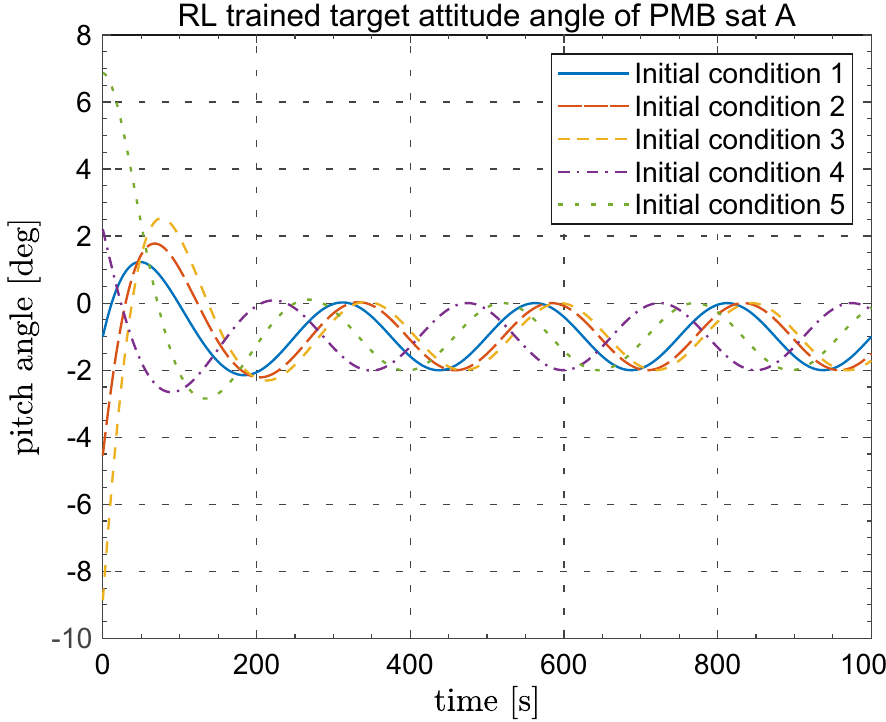
Figure 11. Satellite A pitch maneuver angles under different initial